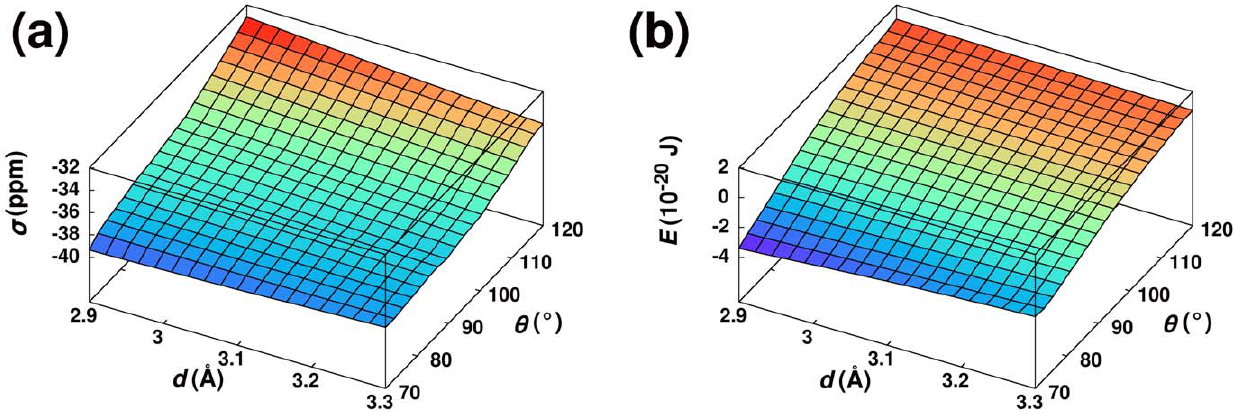
Figure 5. Summary of Quantum Chemical Calculations. Plot of calculated ( A ) carbonyl 13 C chemical shielding ( s ) and ( B ) dipole-dipole interaction energy ( E ) as a function of the distance between donor oxygen and acceptor carbon ( d ) and the angle between carbonyl groups ( h ). See also Figure S3.